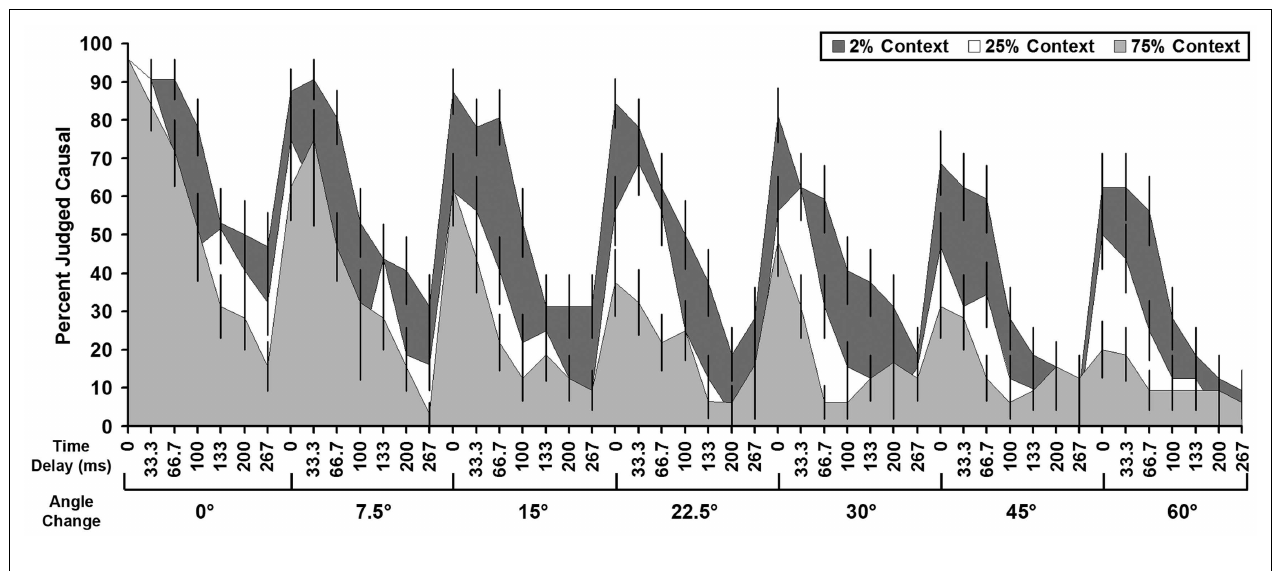
demonstrates more conservative use of spatial and temporal parameters vs. the 25% (white) and 2% (light gray) context conditions. Means for direct launches were calculated based on different numbers of trials in each experiment (Experiment 1 = 2; Experiment 2 = 32; Experiment 3 = 288